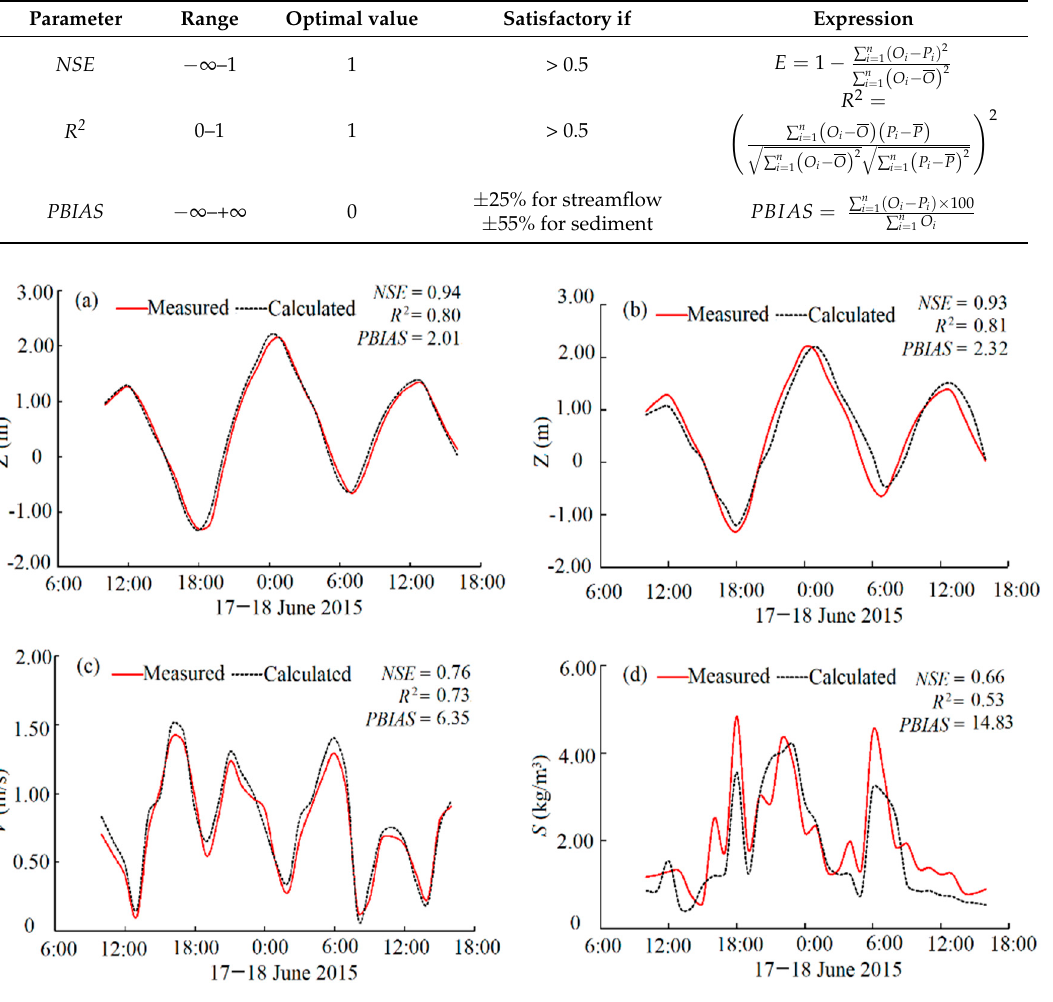
Figure 9. Model calibration with measured versus predicted for the spring tide (June 2015): ( a ) Z at WL4; ( b ) Z at WL5; ( c ) V at FS4; ( d ) S at FS4.